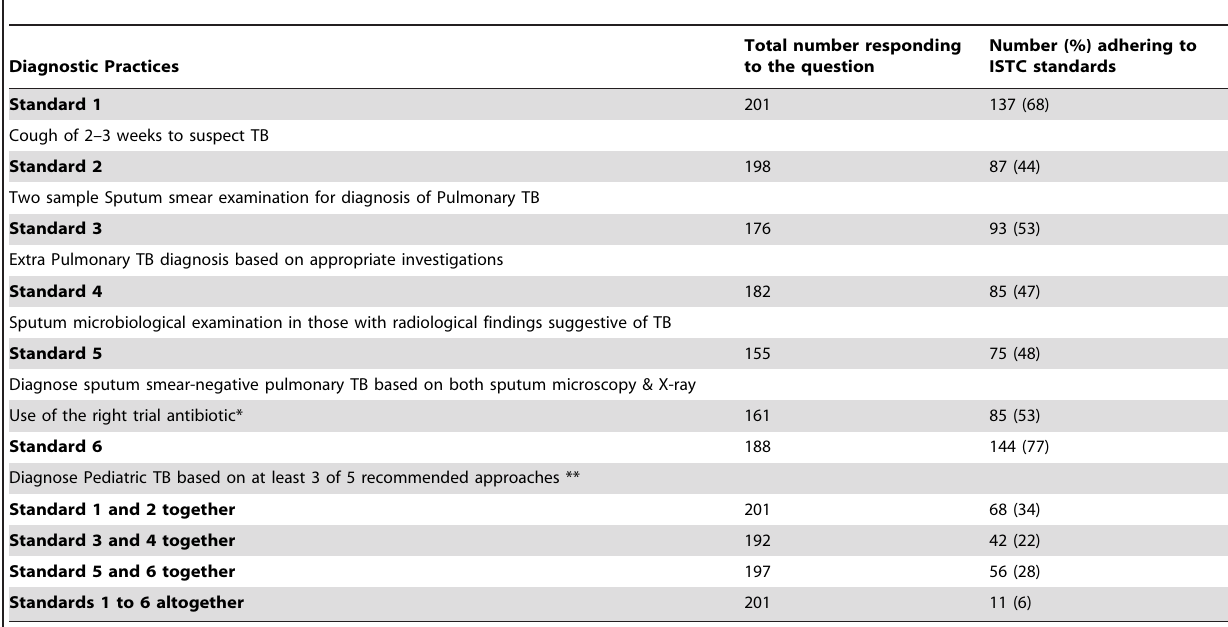
Table 2. Private Practitioners adhering to ISTC * diagnostic practices in Visakhapatnam, Andhra Pradesh.